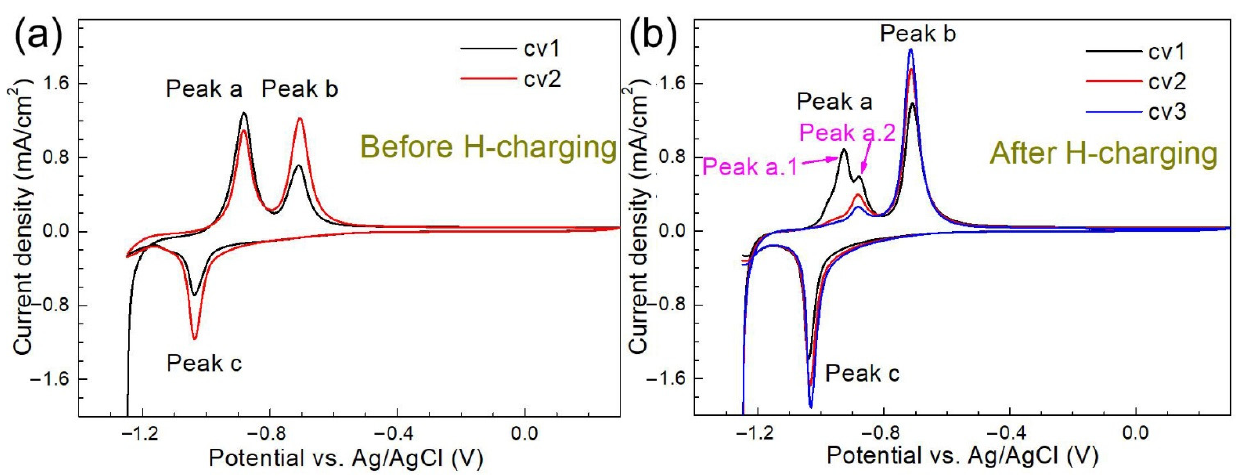
Figure 7. Cyclic voltammograms of the 690 MPa grade steel substrate before ( a ) and after H charging for 30 min ( b ) in NaOH solution containing thiourea (scan rate 10 mV/s).